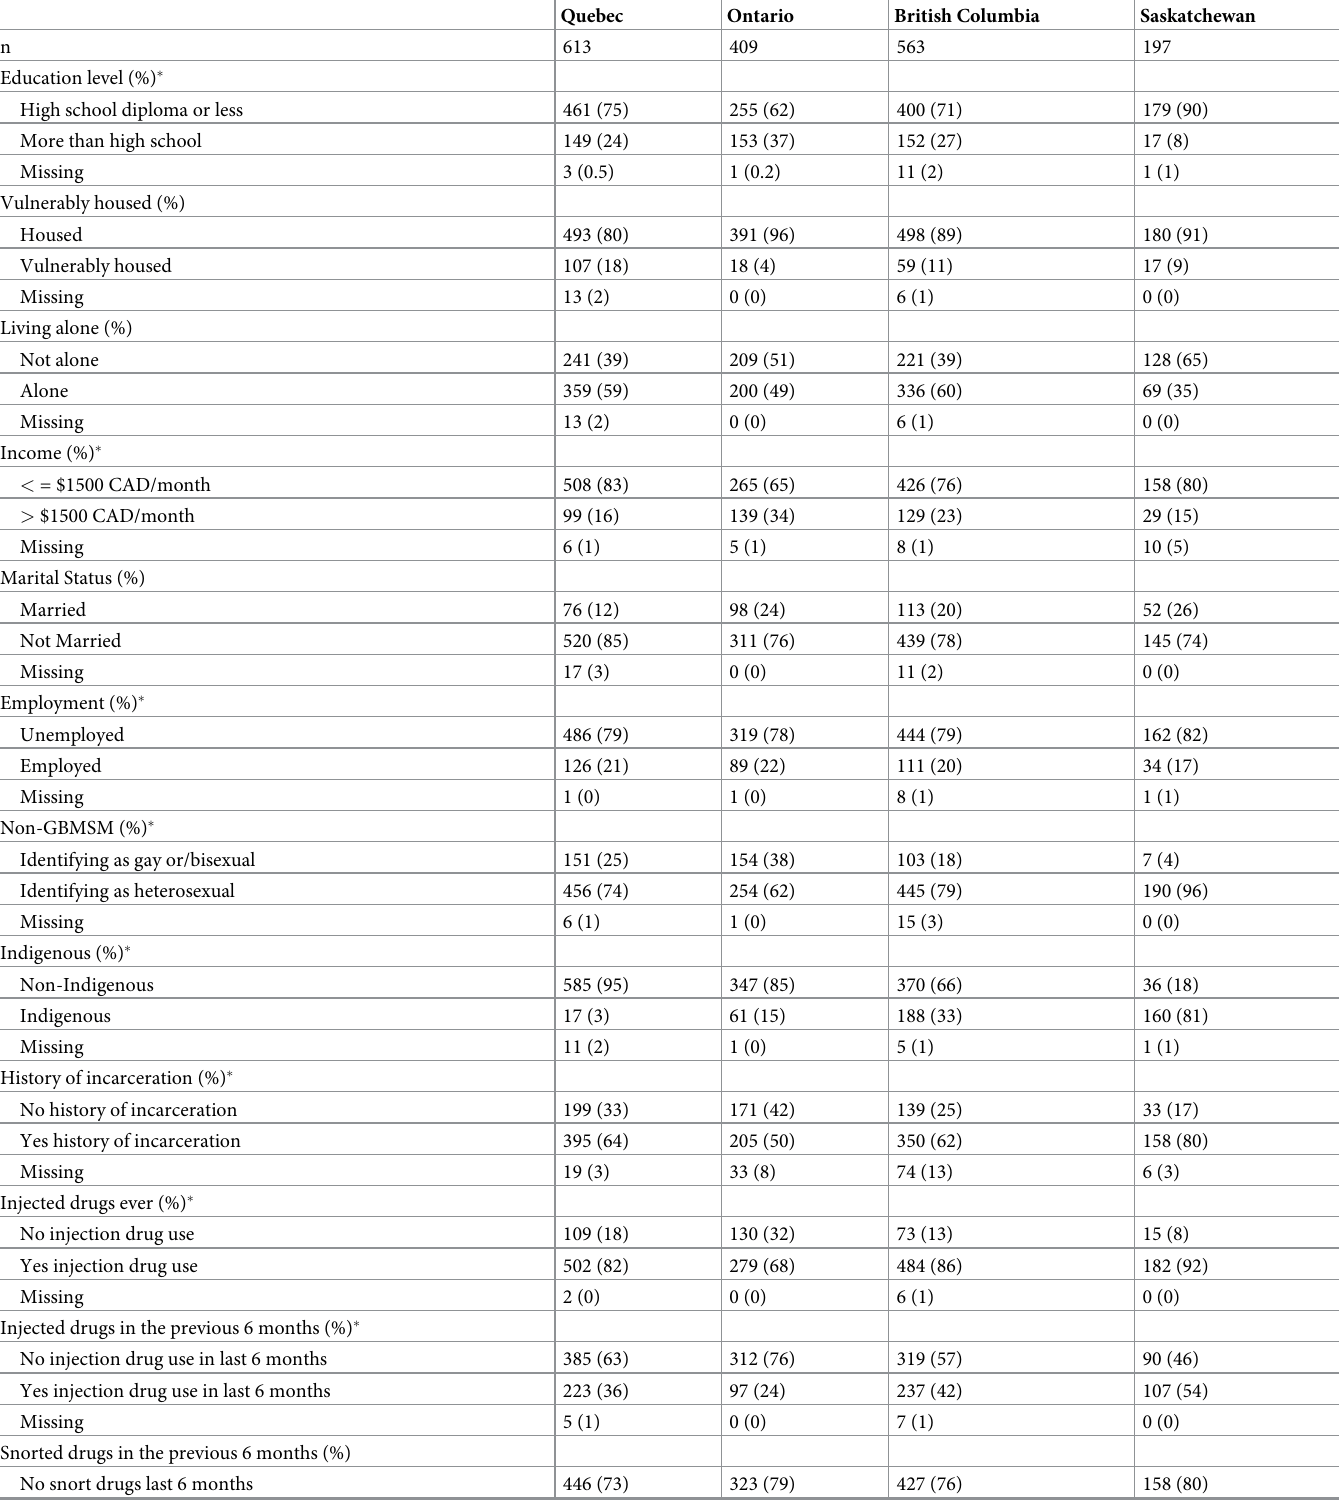
Table 1. Characteristics of the participants at baseline according to variables that were considered for inclusion into the model stratified by